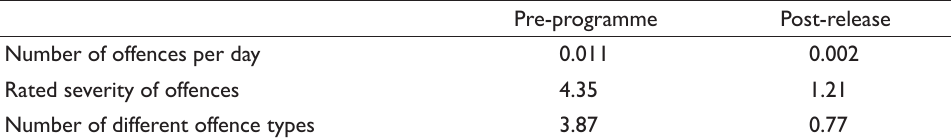
Table 3: Re-offending by prisoner participants pre-programme and post-release